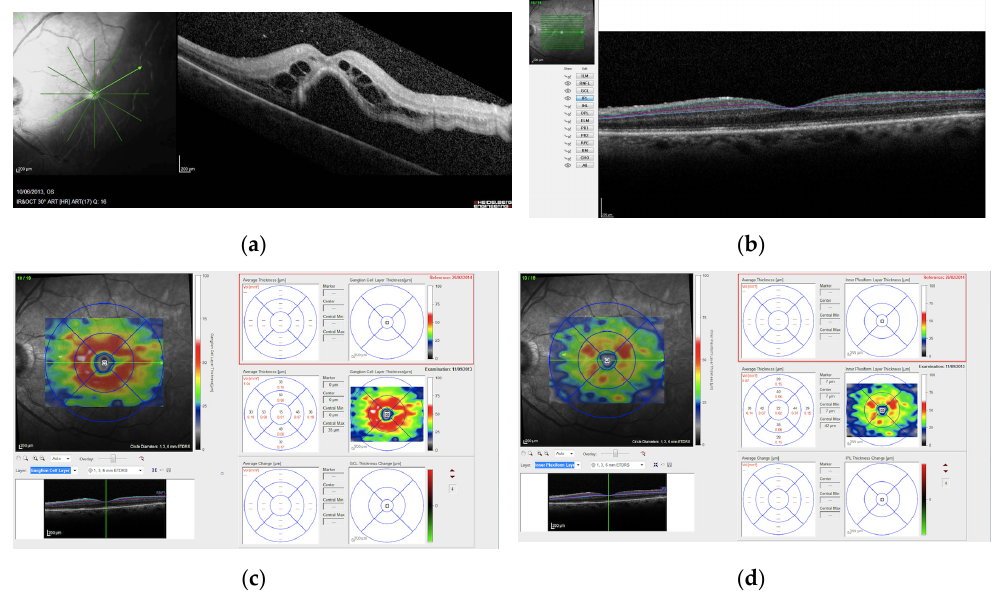
Figure 1. ( a ) Preoperative infrared and SD ‐ OCT B scan images of a patient with macula ‐ off RRD undergoing PPV surgery; ( b ) postoperative ganglion cell (GCL) and inner plexiform (IPL) layers automated segmentation, where the turquoise line represents the boundary between the retinal nerve fiber layer and the GCL, the purple line represents the boundary between the GCL and IPL, and the blue line represents the boundary between the IPL and the inner nuclear layer; postoperative retinal thickness maps showing average GCL ( c ) and IPL ( d ) thickness in the ETDRS grid. The magnification scale of all OCT images is 200